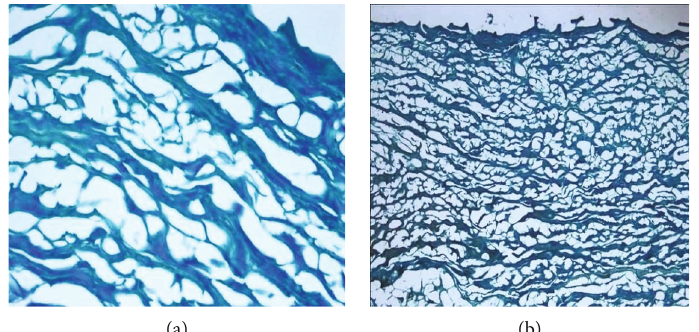
Figure 6: Human-derived derm-skin after removal of the epidermis, fat tissues, blood vessels, and debris part: (a) H-SG stain, magni fi cation 60x; (b) H-SG stain magni fi cation 10x.